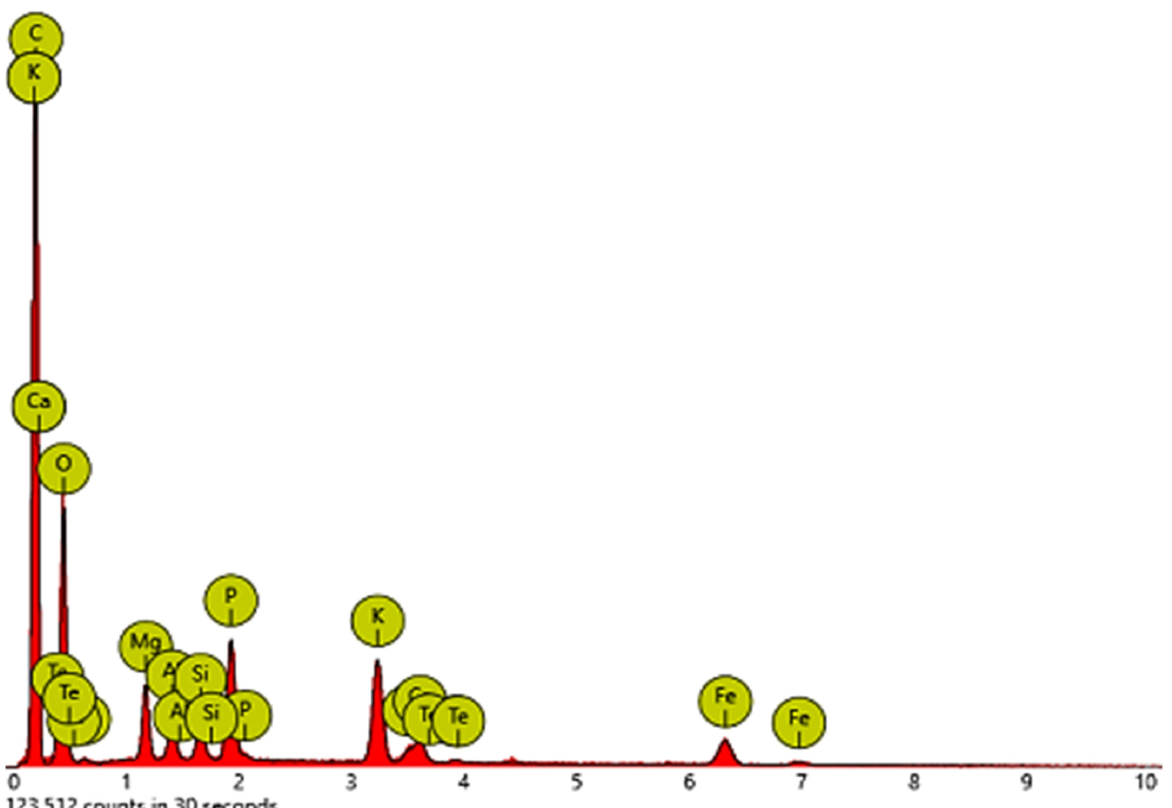
Figure 2. Mineral elements in groundnut cake (GNC) ash. Mineral elements in GNC ash were recorded in five positions by the generation 5 phenom pro and proX SEMs machine and the position of all elements are presented in the above representative picture. Table 1. The nutrient content of groundnut cake (GNC) .